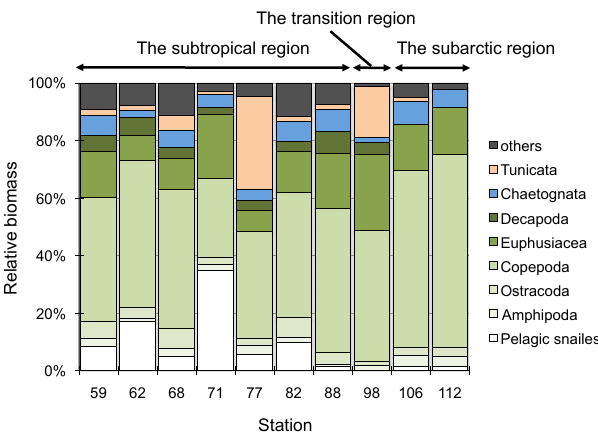
Fig. 4. Major taxa compositions of zooplankton between 0 and 200m in depth from January to February 2012 in the western North Pacific Ocean. Compositions are based on the dry weight. Stations from 59 to 88 were located in subtropical region, station 98 was in the transition region, and stations 106 and 112 were in subarctic